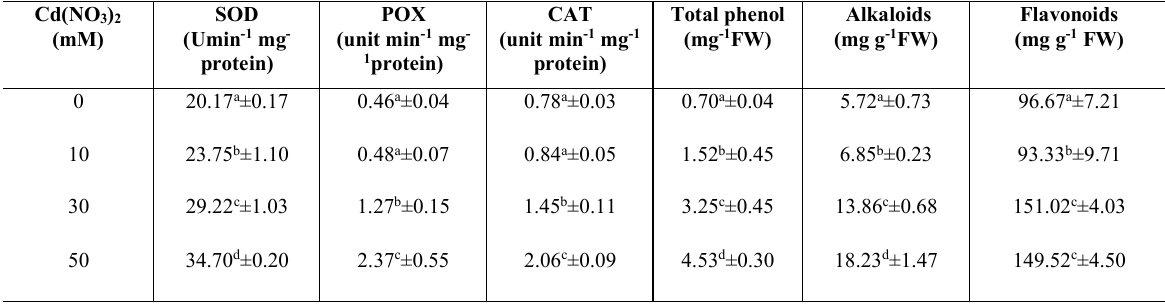
Table 4. Effect of different concentrations of Cd(NO 3 ) 2 on the activity of ROS scavenger enzymes (SOD, POX and CAT), total alkaloids, felavonoids and phenolic compounds of C. roseus callus cells after 3 days of treatment.